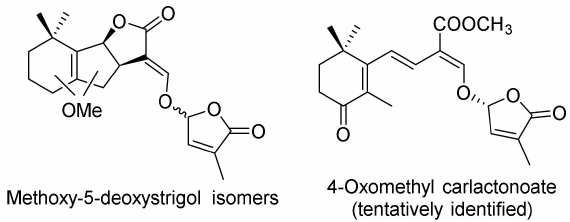
Figure 4. Possible structures of not yet characterized